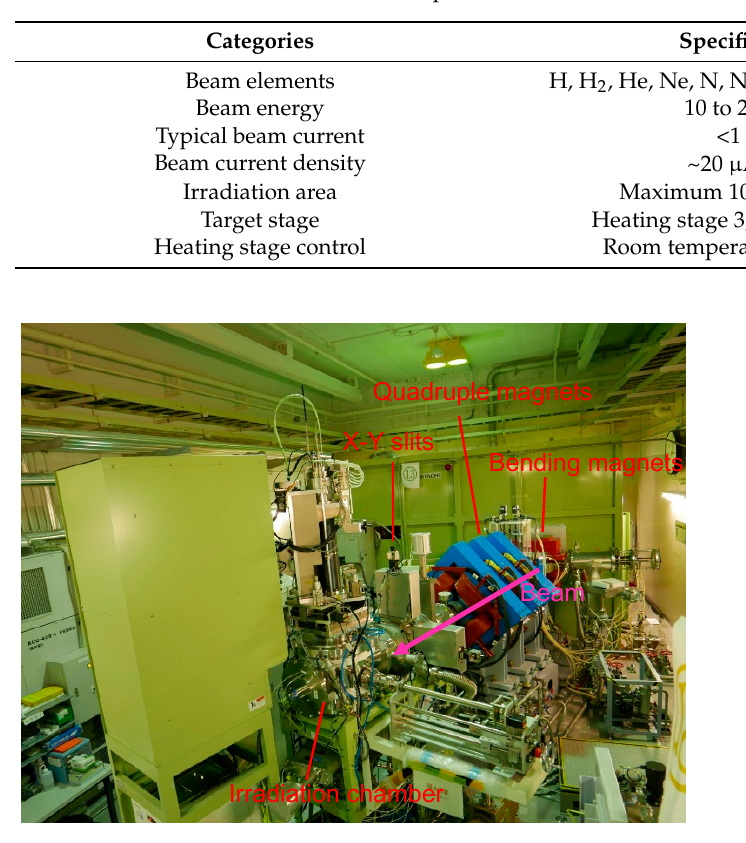
Figure 7. Beamline and irradiation chamber of the ion-implanter.